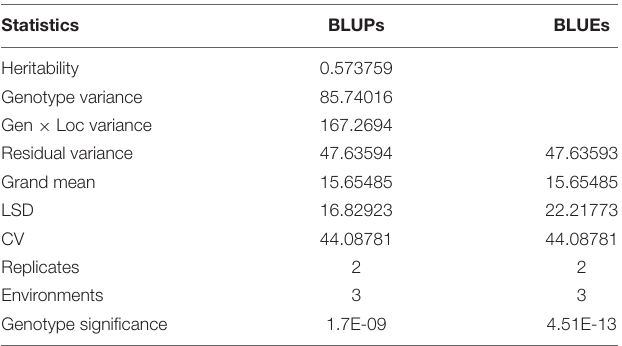
TABLE 1 | Combined analysis of variance of 141 advanced lines evaluated for stripe rust disease resistance for disease severity recorded for three